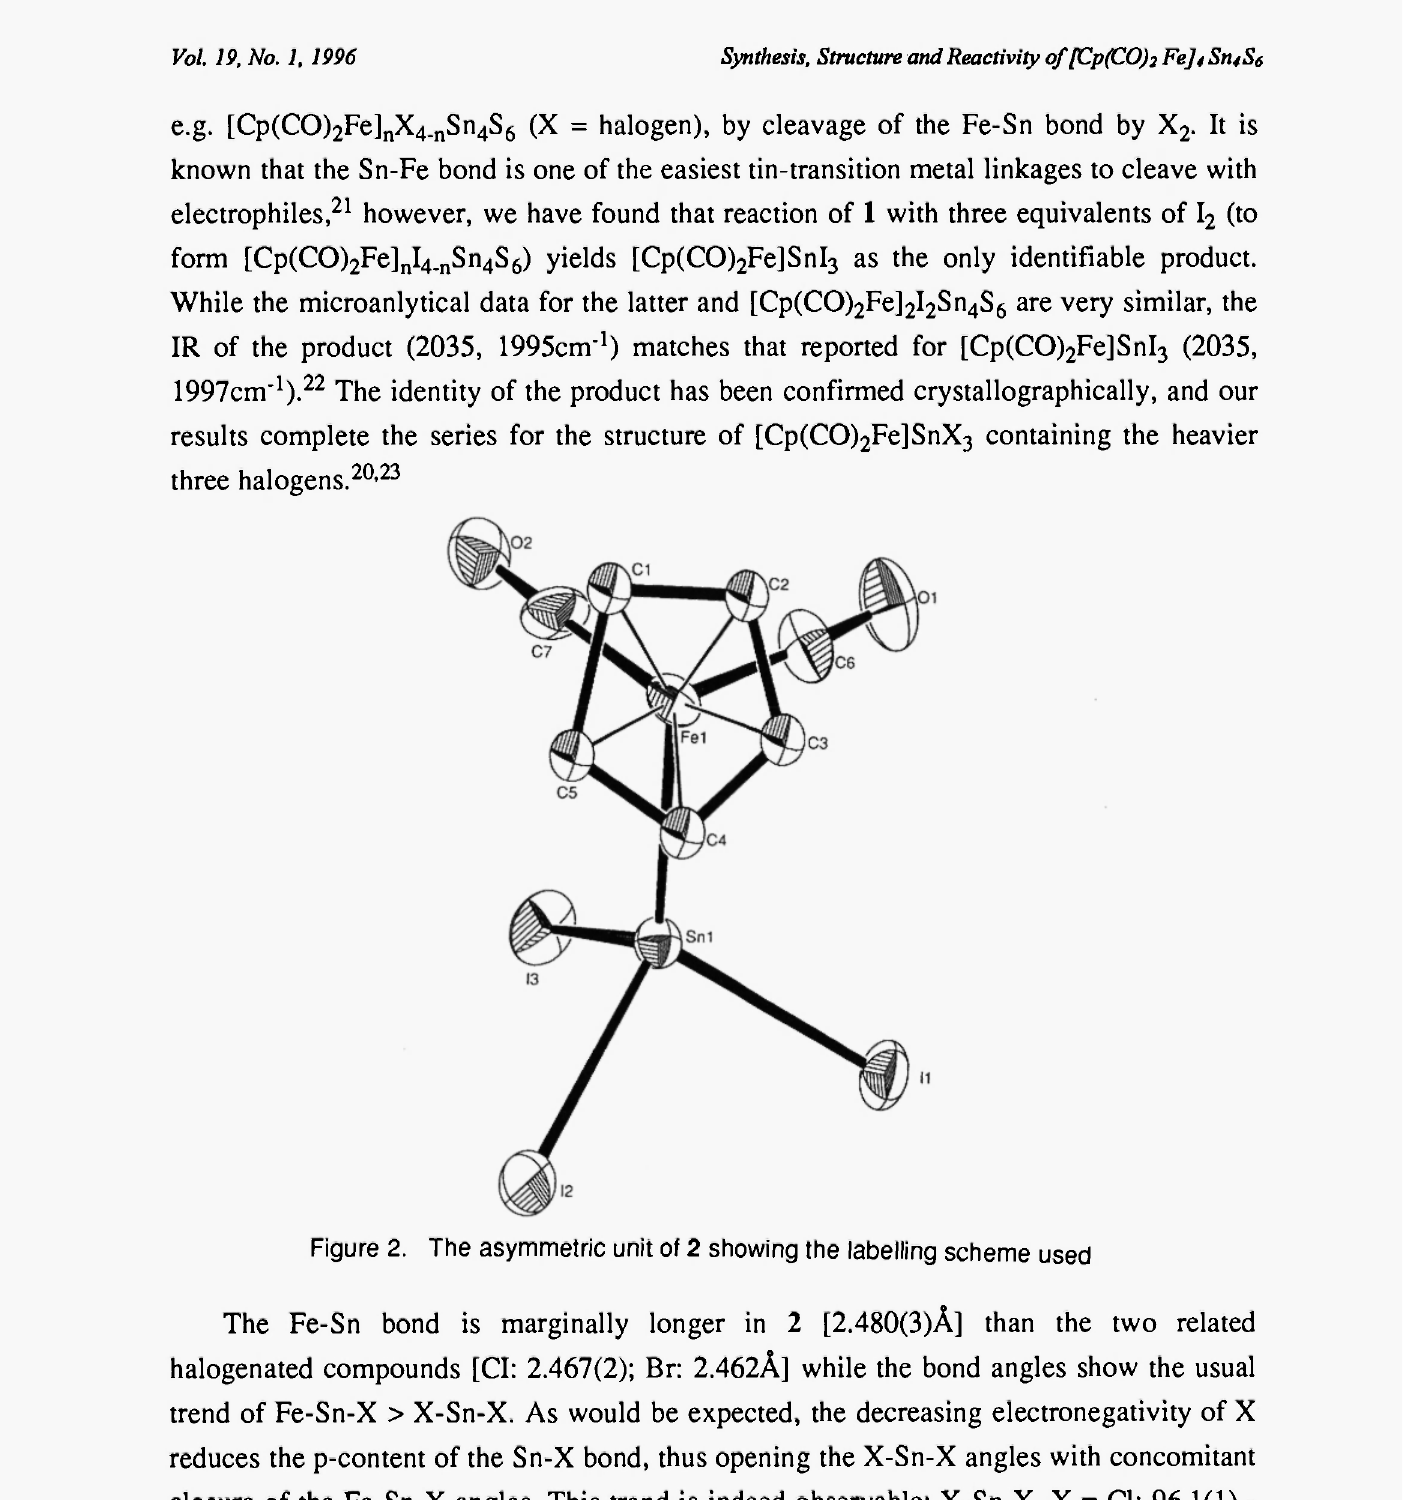
Figure 2. The asymmetric unit of 2 showing the labelling scheme used The Fe-Sn bond is marginally longer in 2 [2.480(3)Ä] than the two related halogenated compounds [CI: 2.467(2); Br: 2.462Ä] while the bond angles show the